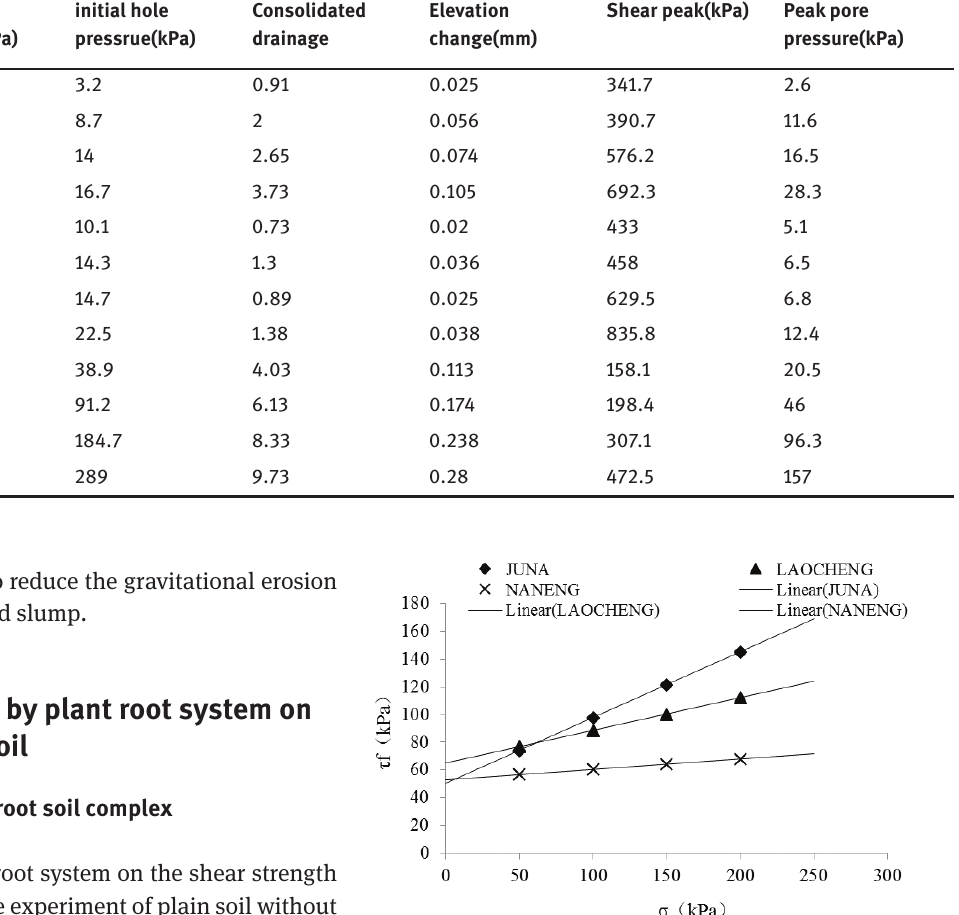
Table 6: Changes of soil mechanical properties in three axis tests of consolidated drainage in 3 watersheds. Watershed Vertical